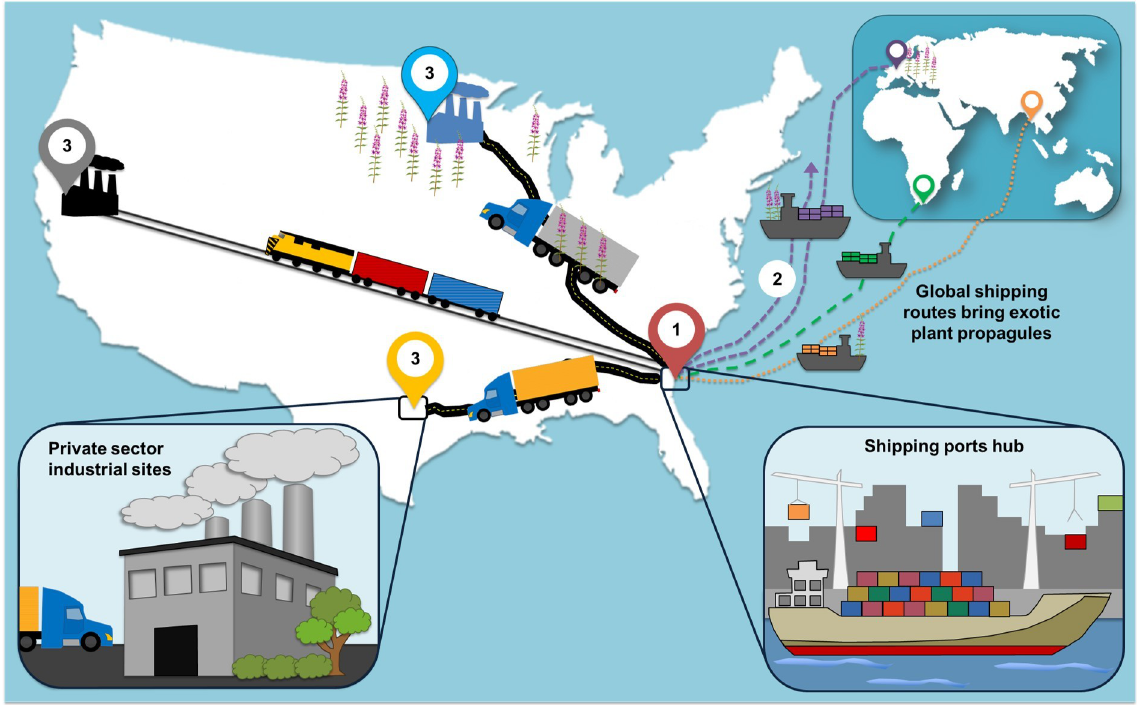
Fig 2. With a concerted effort, botanists should begin monitoring and researching at industrial sites to determine propagule pressure, environmental conditions, disturbance regimes, connectivity among sites, botanical species richness, and invasive species abundance to assess environmental risk of species invasion that current practices allow or promote. Through international trade, (1) global shipping routes bring exotic plant propagules to ports that function as hubs of industrial activity. (2) Sometimes through effective monitoring and detection, contaminated shipments are turned away and sent back to the nation of shipment origin. (3) Upon arrival, shipments (including those that are possibly contaminated) are rapidly sent up to thousands of kilometers away from the port-of-origin to private-sector industrial and commercial sites. Figure created by Ashley N.